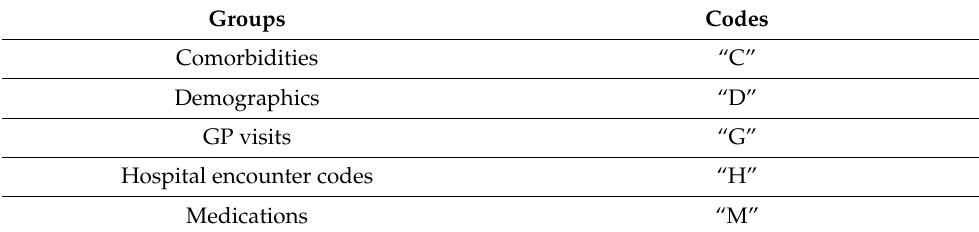
Figure 3. An overview of VERONICA. Table 3. Groups and their representing